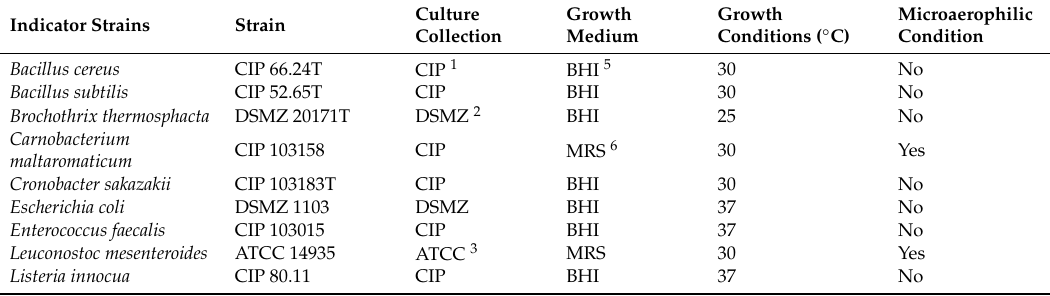
Table 3. Growth media and growth conditions of food-spoilage and foodborne bacteria used as indicator